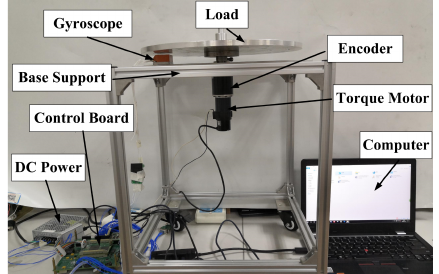
Figure 5. Experimental